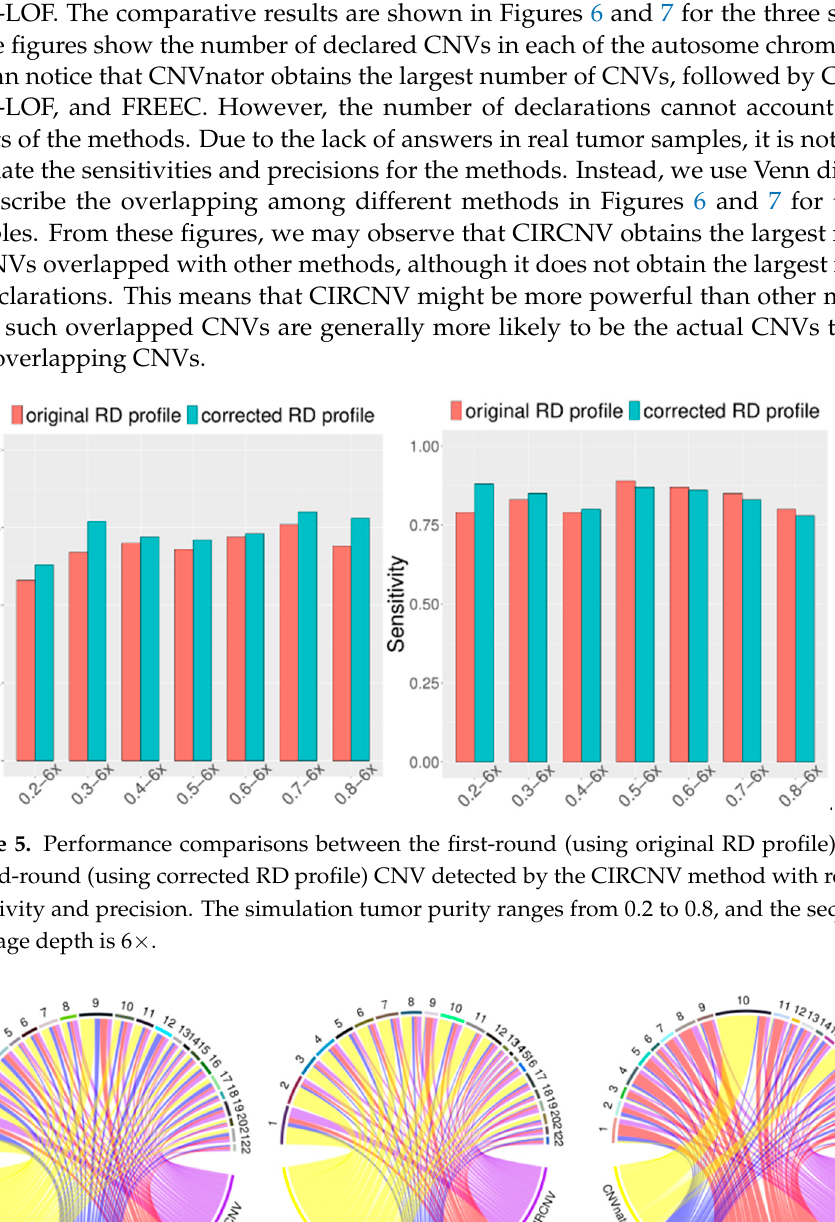
Figure 6. Result comparison of the four methods on the whole-genome sequencing data from samples of EGAR00001004802_2053_1 ( I ), EGAR00001004802_2053_1 ( II ), and EGAD00001000144_LC ( III ). The distributions of the numbers of CNVs detected by the four methods and the numbers of detected CNVs in each autosome